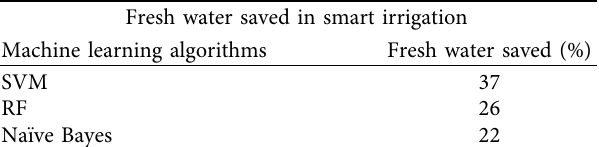
Table 2: Fresh water saved in smart irrigation.